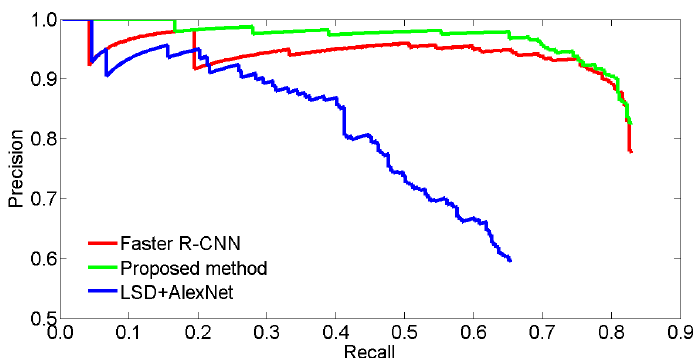
Figure 13. Precision-recall curves.